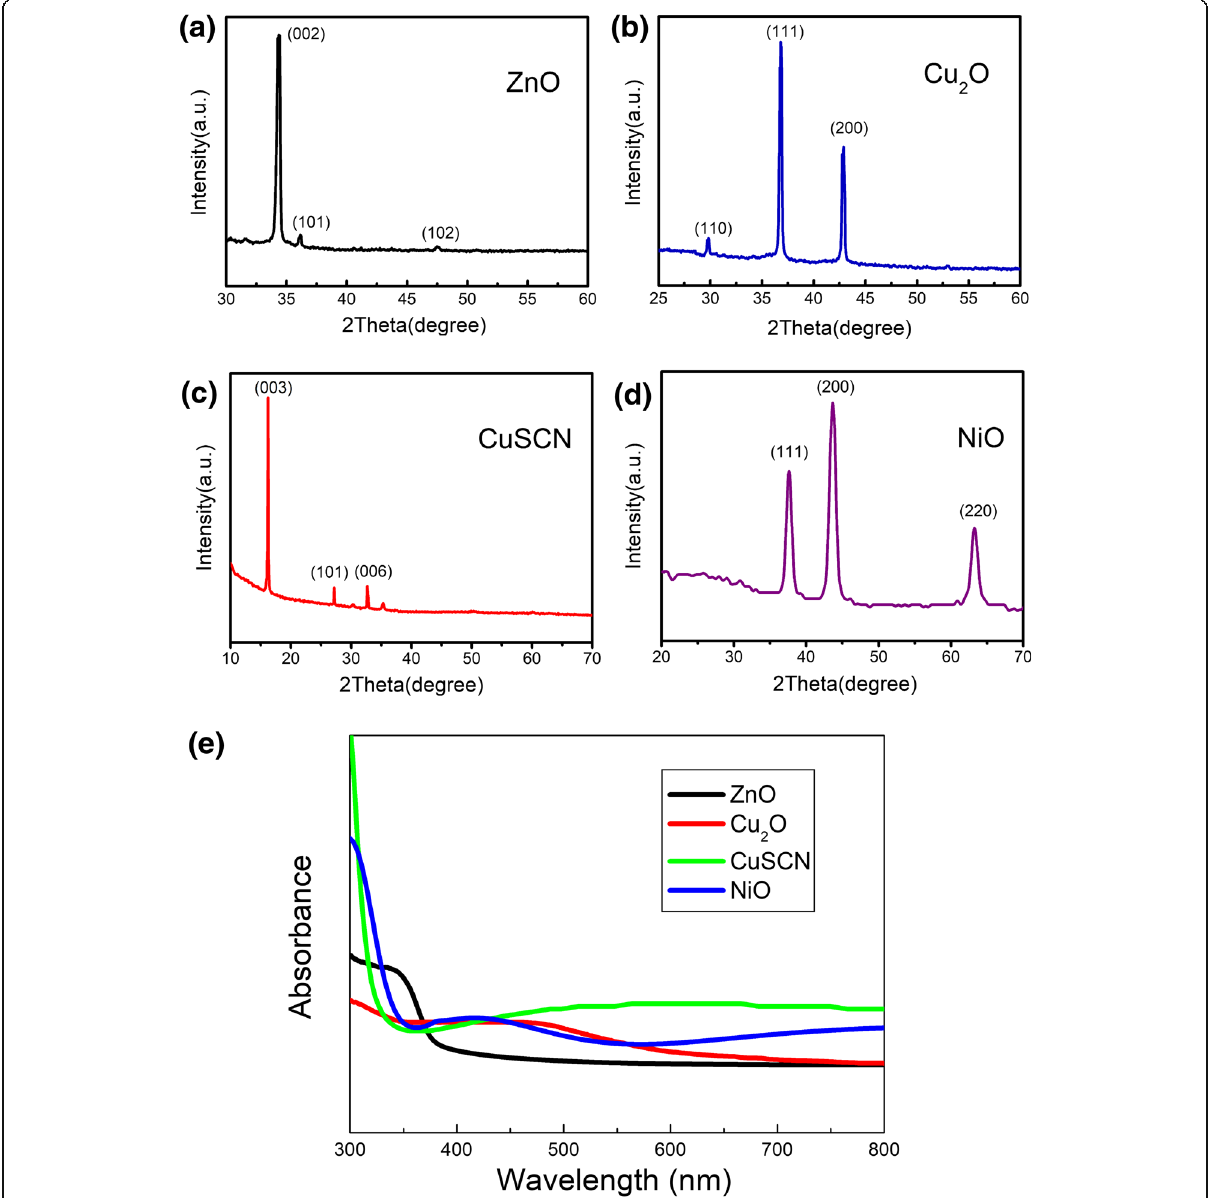
Fig. 1 X-ray photoelectron spectra of ZnO ( a ), Cu 2 O (pH10, 20min) ( b ), CuSCN (3D) ( c ), and NiO (1min) ( d ) nanostructures prepared by electrodeposition method and the absorbance spectra ( e ) of ZnO, Cu 2 O (pH10, 20min), CuSCN(3D), and NiO(1min) nanostructures prepared by electrodeposition